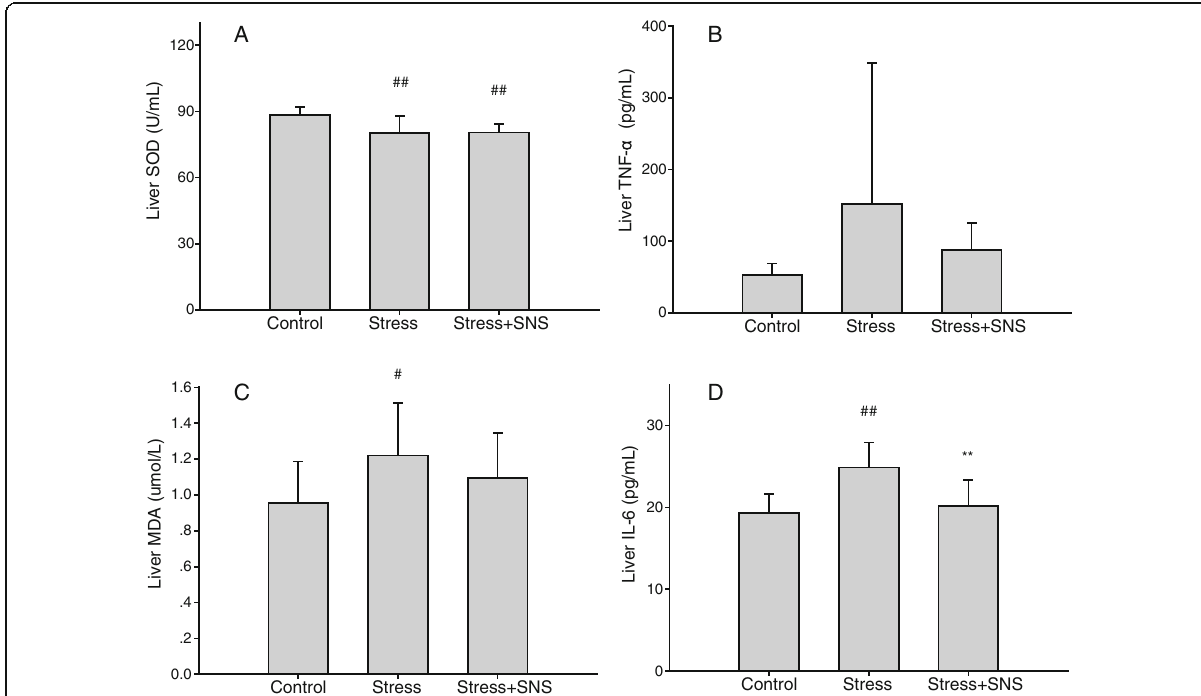
Fig. 5 The oxidative stress and inflammation of the liver. a The superoxide dismutase (SOD) level of each group. b The tumor necrosis factor (TNF)- α level of each group. c The malondialdehyde (MDA) level of each group. d The liver interleukin (IL)-6 level of each group. Values plotted are a mean ± standard deviation ( N = 10 per group). # p < 0.05, ## p < 0.01 versus the control group, ** p < 0.01 versus the stress